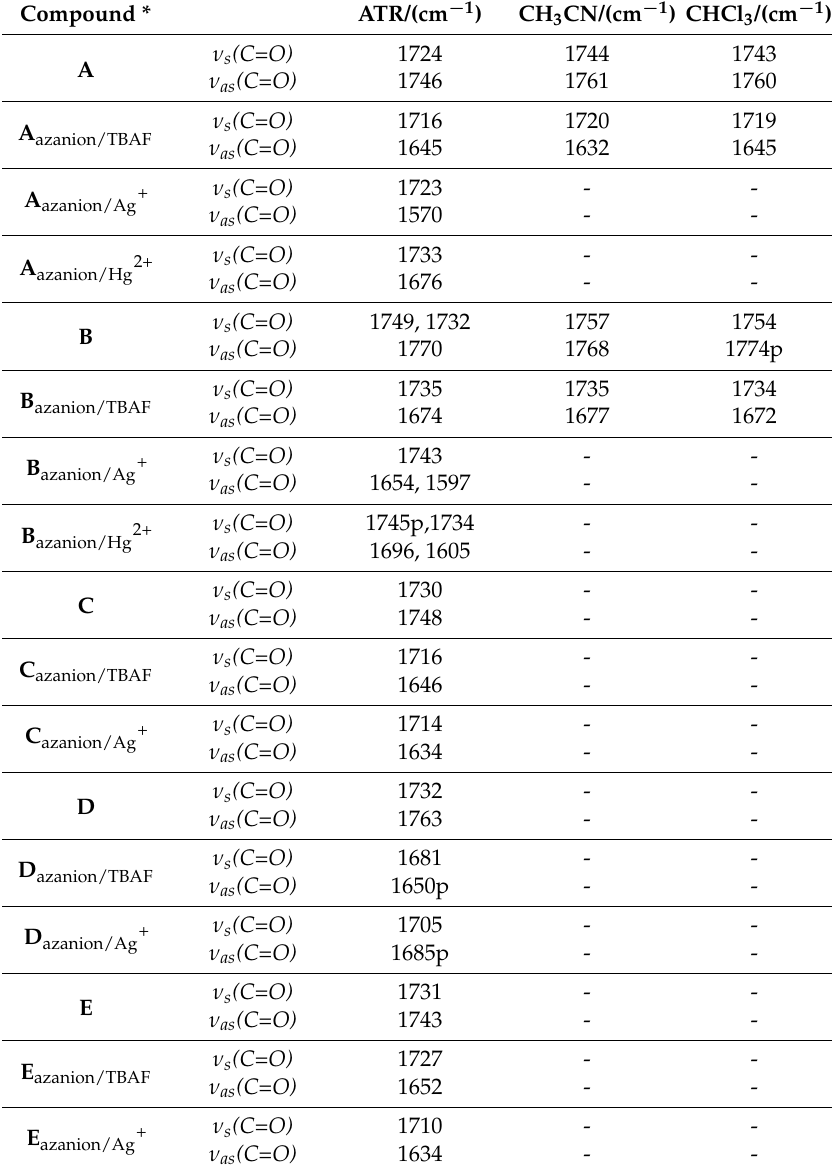
Table 3. Position of the absorption maxima A – E isatin derivative carbonyls ( ν s (C=O) , ν as (C=O)) and their azanions ( A – E